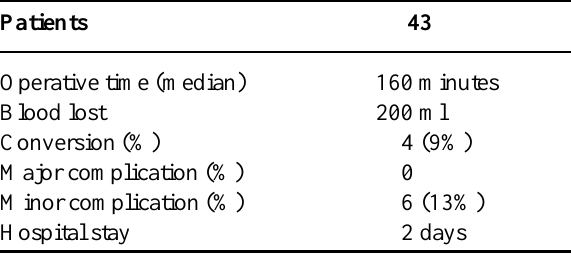
Table 2 – Surgical